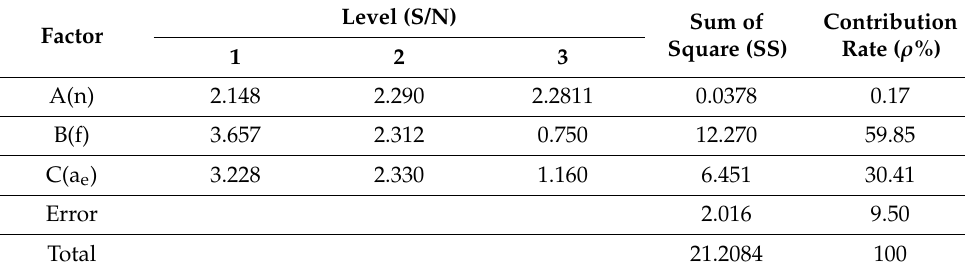
Table 4. Unassisted milling (Si 3 N 4 ) surface roughness variance analysis.